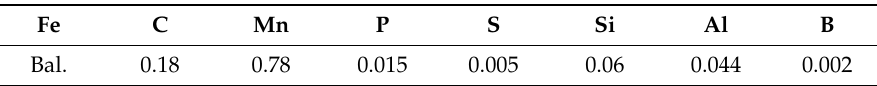
Table 1. Chemical composition of 10B21 steel (wt. %).